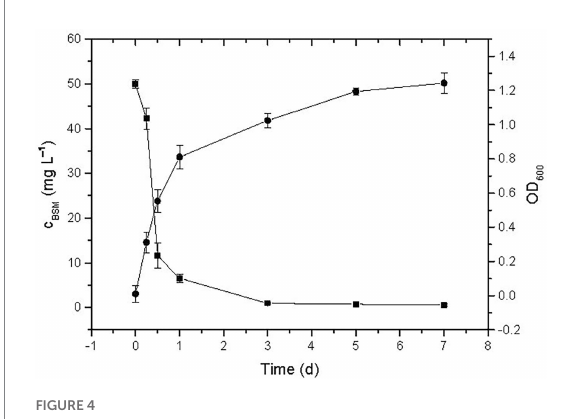
FIGURE 4 BSM residue ( ▪ ) and concomitant growth of strain CD3 (•) in MMG with 50 mg L − 1 BSM under the optimal